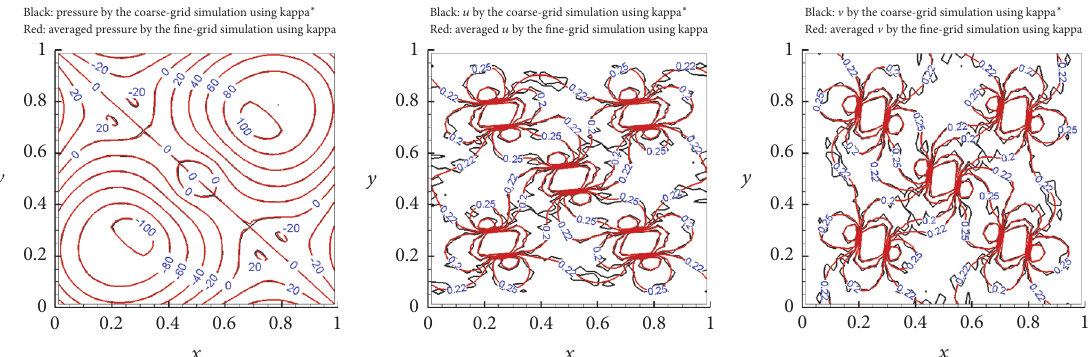
Black: pressure by the coarse-grid simulation using kappa ∗